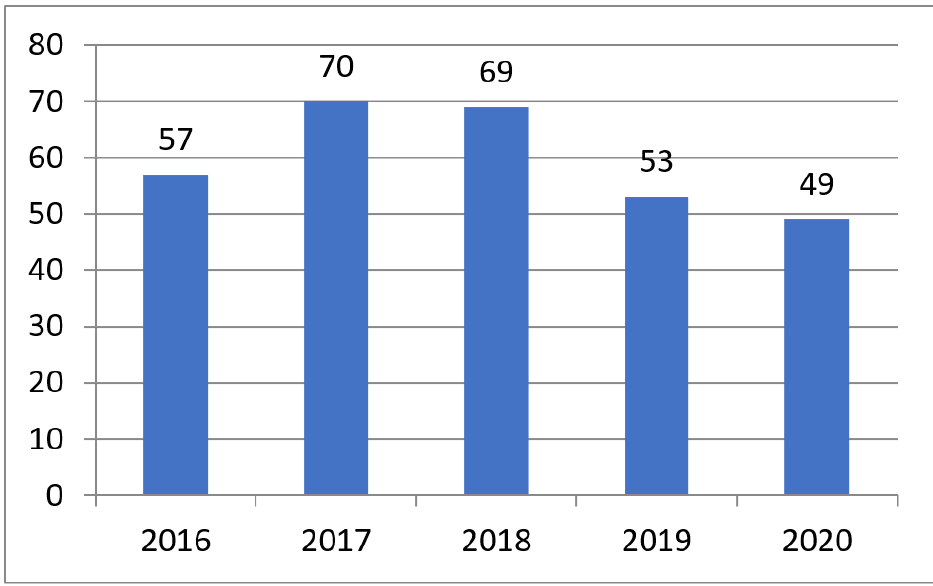
Figure 6. Gazprom Group expenses on environmental protection and rational use of natural resources, in billion rubles [80].